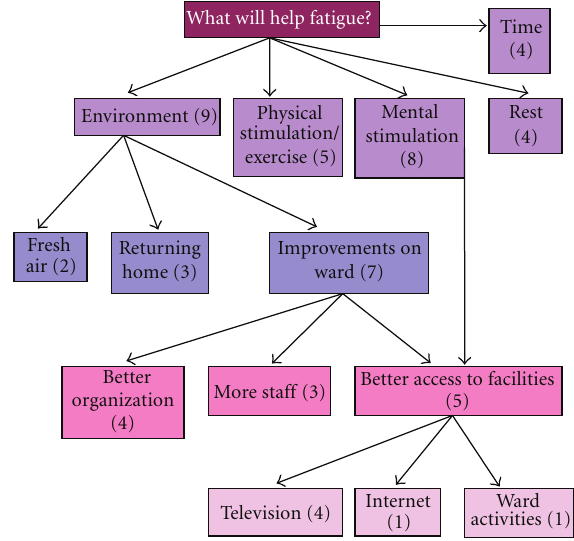
Figure 3: Factors that might help